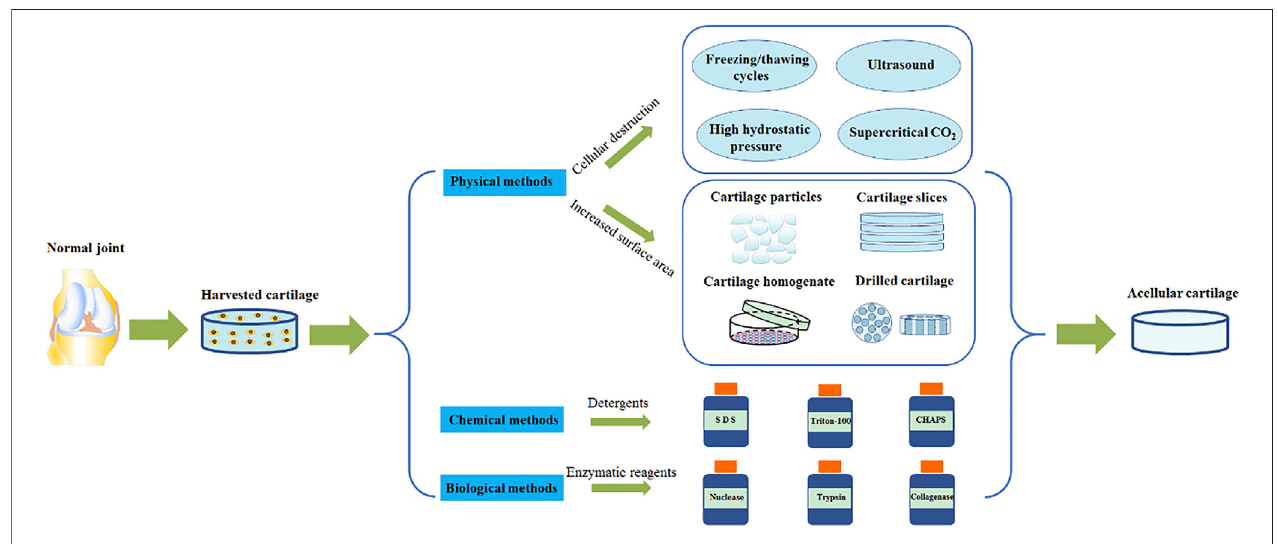
FIGURE 2 | AC tissue decellularization.